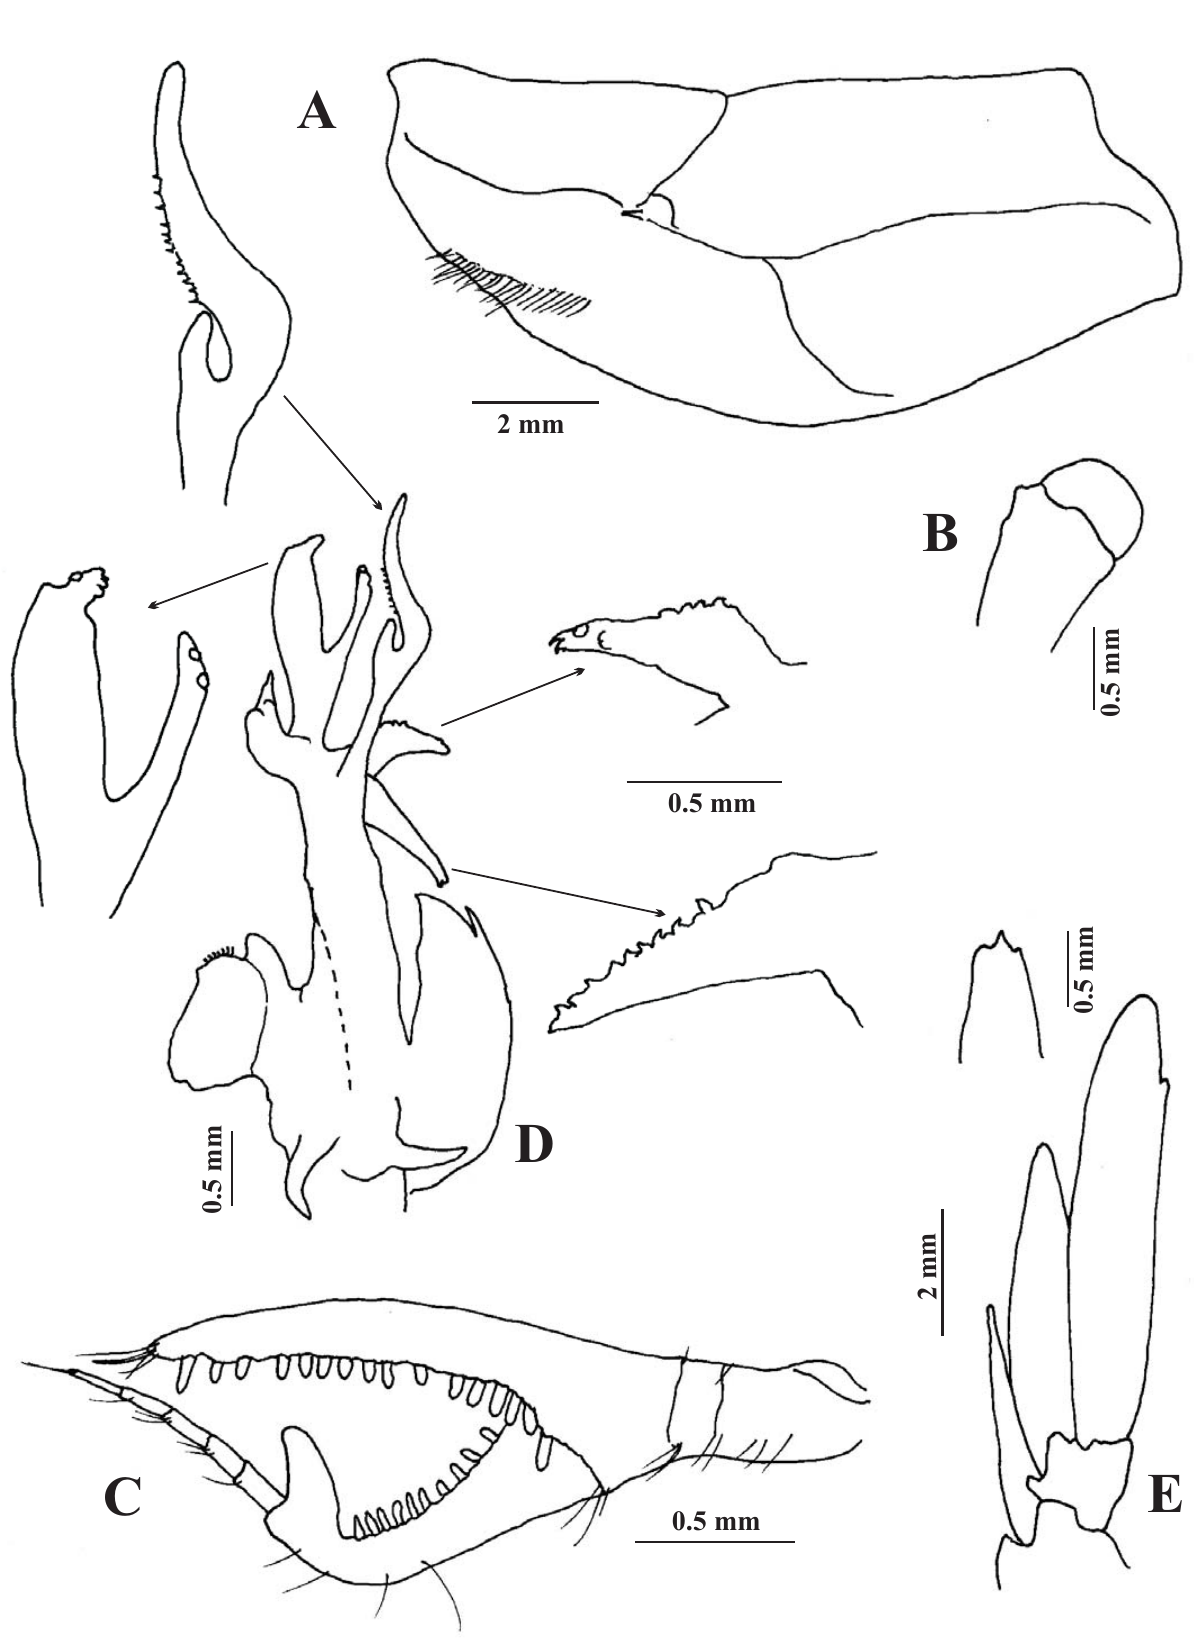
Figure 2. Petalidium suspiriosum Burkenroad, 1937 (ICML-EMU-8097), male (CL 10.2 mm). A, Carapace, lateral view; B, eye, dorsolateral view; C, inferior antennal flagellum, medial view; D, left petasma, anterior view; E, telson and uropods, lateral view (setae